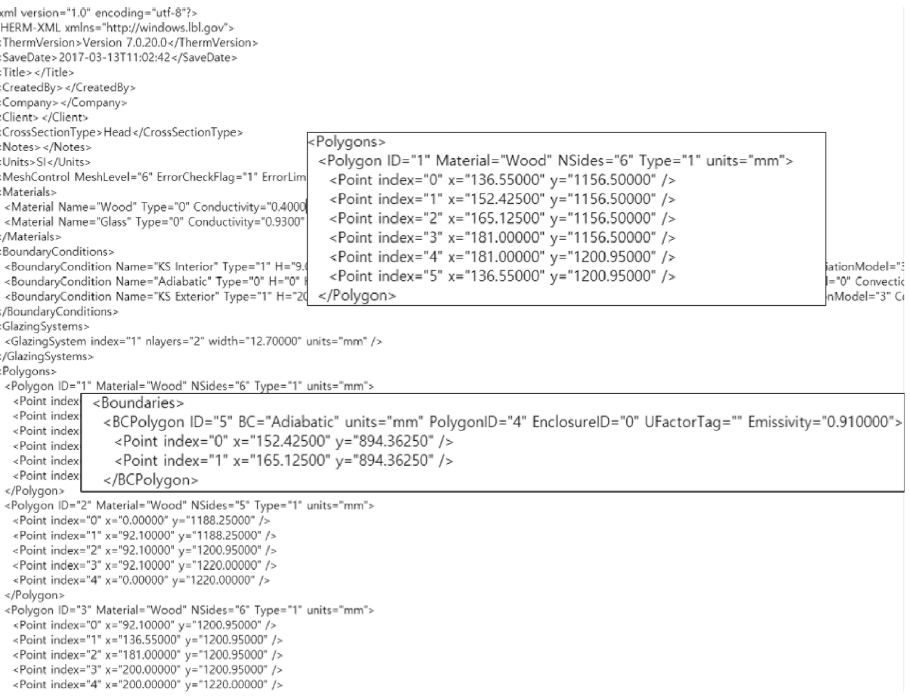
Figure 10: THMX output result of test case